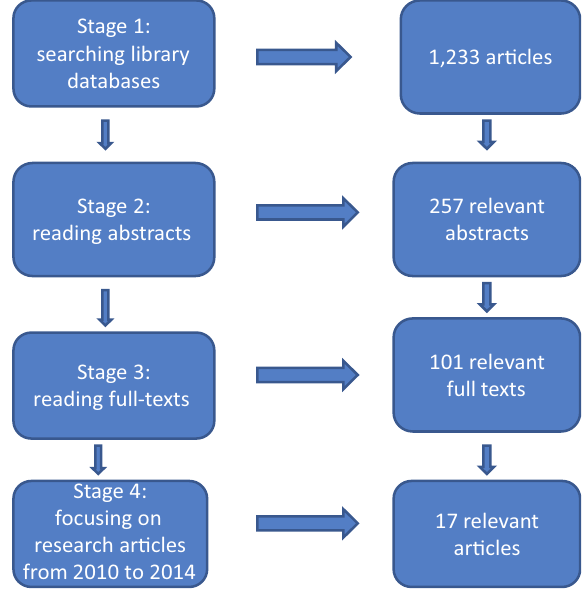
Figure 3. Showing the selection process of relevant sources Adapted from: Schaefer-McDaniel et al.